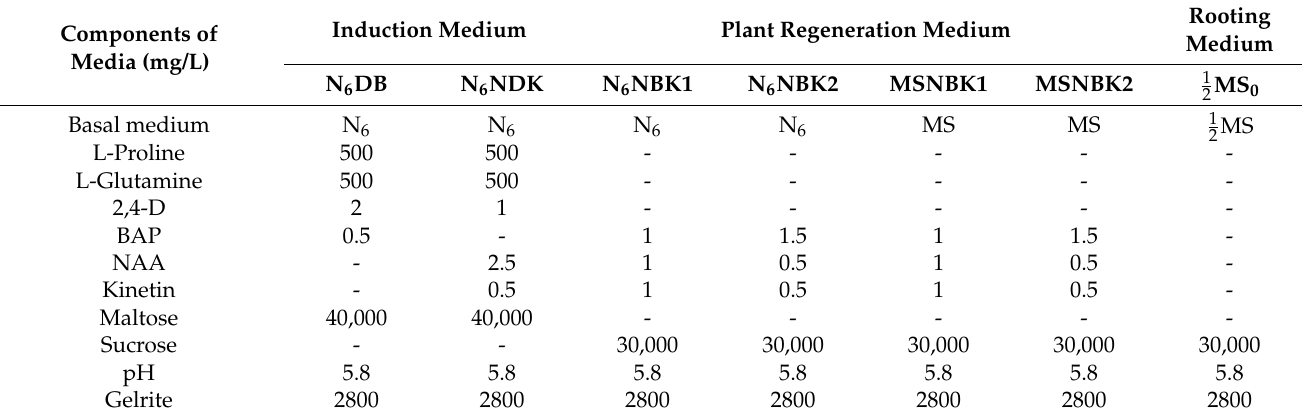
Table 9. The components of induction, plant regeneration and rooting media in rice